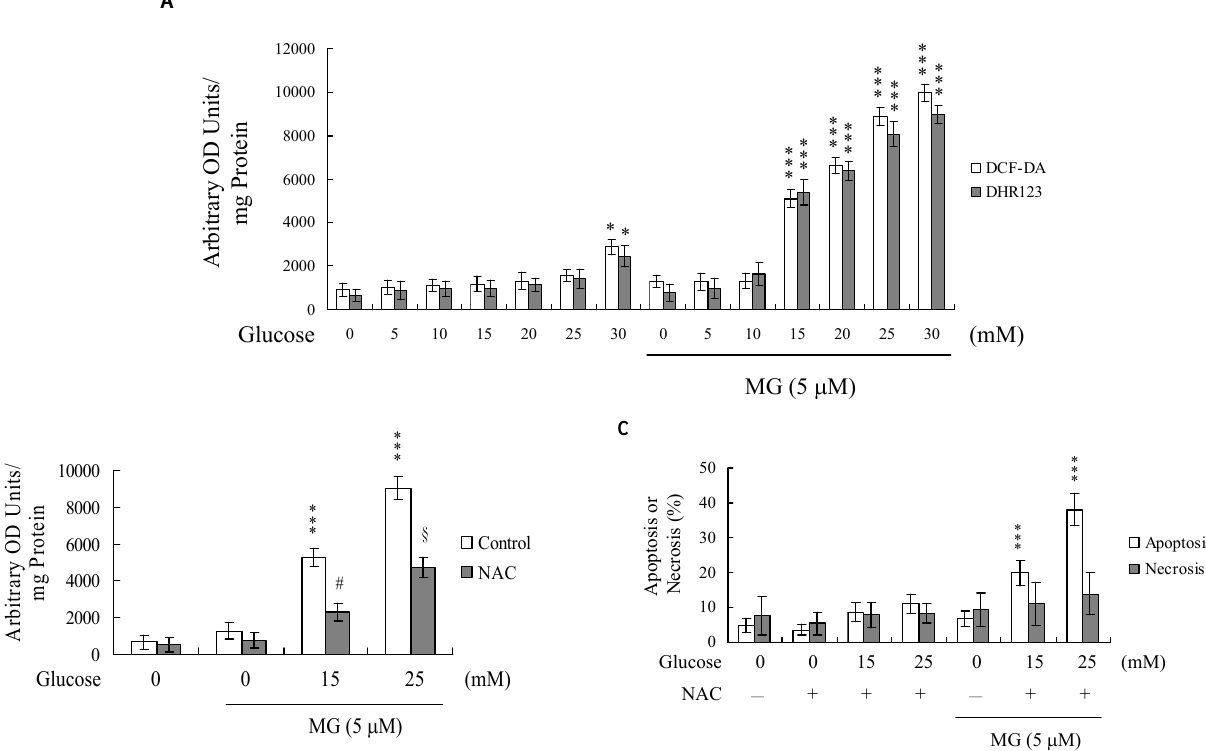
Figure 1. Data are representative of eight independent experiments. ***P < 0.001 versus the untreated control group. #P < 0.001 versus the “MG + HG (15 mM)” group. §P < 0.001 versus the “MG + HG (25 mM)”